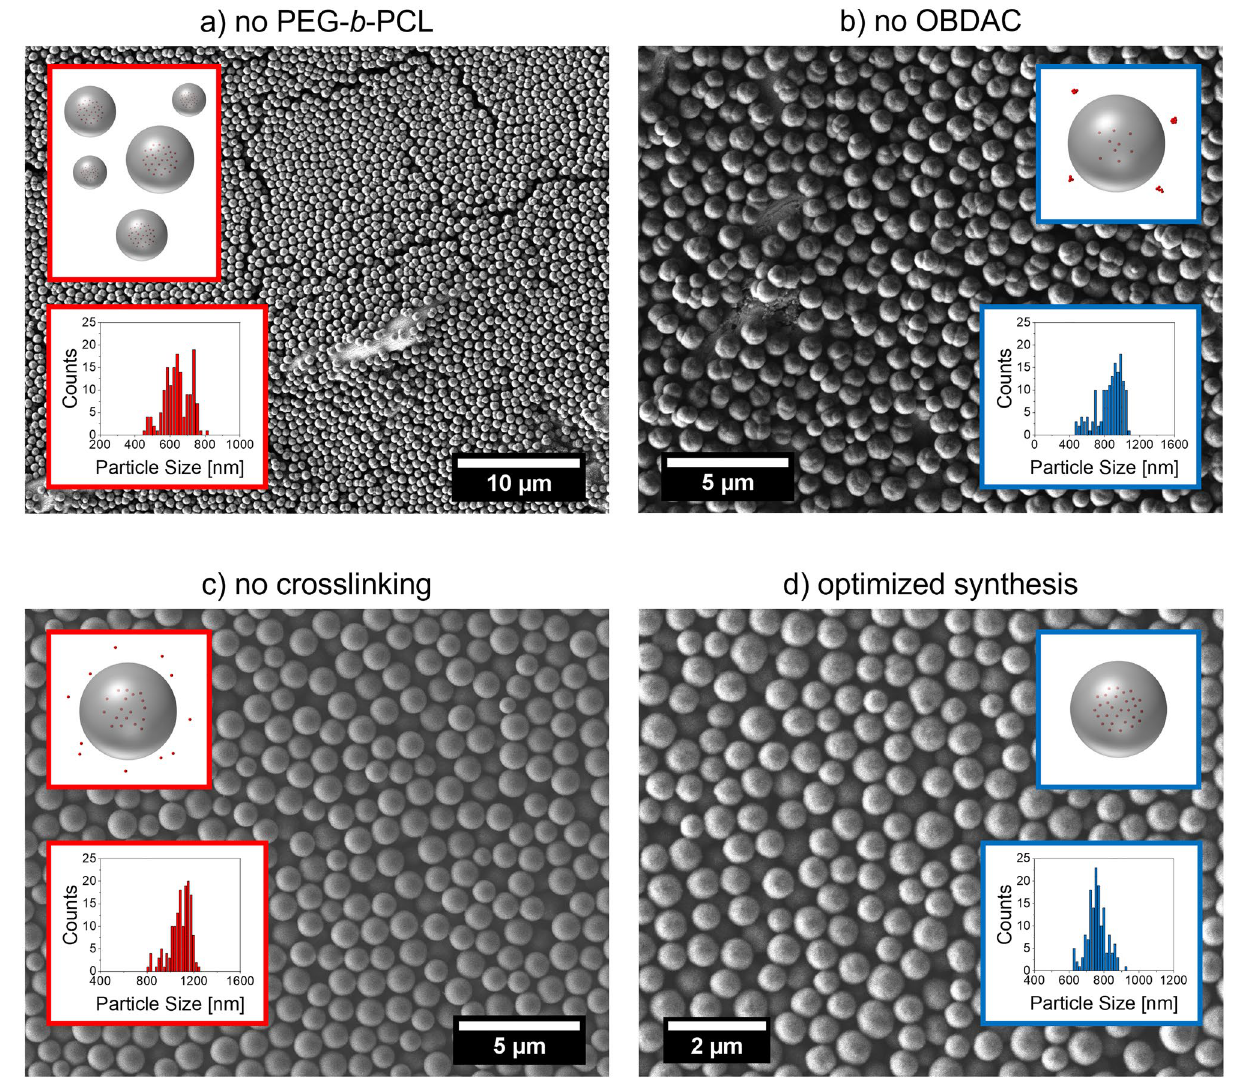
Figure 5. SEM images with the schematic presentation of the CdSe/CdS-encoded microbeads and the size distribution, synthesized from ( a ) OBDAC-coated, OA/OLA-stabilized CdSe/CdS-QDs and styrene (36.6 mg AIBN, toluene added without PEG- b -PCL, 200 µL DVB), ( b ) OA/OLA-stabilized CdSe/CdS-QDs and styrene in the presence of the copolymer PEG- b -PCL (36.6 mg AIBN, 36.6 mg PEG- b -PCL, 200 µL DVB), ( c ) OBDAC- coated, OA/OLA-stabilized CdSe/CdS-QDs and styrene in the presence of PEG- b -PCL without the crosslinker DVB (100 mg AIBN, 36.6 mg PEG- b -PCL), and ( d ) OBDAC-coated, OA/OLA-stabilized CdSe/CdS-QDs and styrene with the optimized procedure (36.6 mg AIBN, 36.6 mg PEG- b -PCL, 200 µL DVB). Reaction conditions for all: 75 °C, 70 rpm stirring speed, 24 h reaction optical properties of the oleic acid (OA)/oleylamine (OLA)-stabilized CdSe/CdS-QDs were examined by TEM as well as absorption and PL spectroscopy and the QD concentration of the dispersion used was determined by AAS (for both see SI, Fig. S2). As a tool for bead quality, we focused here first on the PL properties of the QD- encoded beads with special emphasis on the spectral position and spectral width (FWHM: full width at half maximum) of the QD emission band, which correlate with QD size and size distribution, and PLQY which is independent of bead size and the number of incorporated QDs. The structure-analytical characterization of the different types of QD-encoded beads obtained from QDs with different surface chemistries and without and in the presence of a crosslinker are detailed in the following section, thereby assessing features such as bead size, size distribution, and surface morphology as well as QD distribution within the beads.